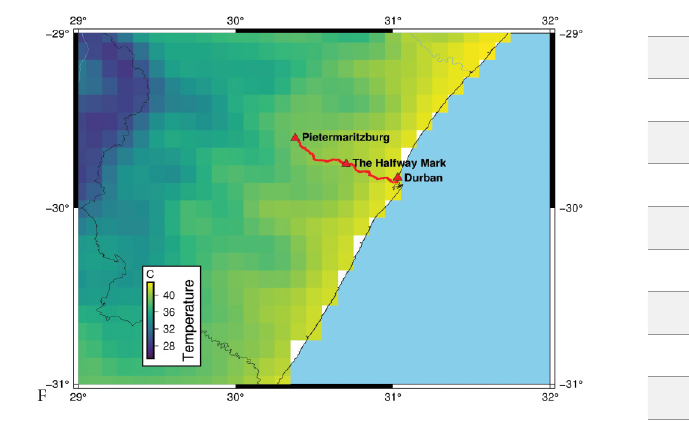
Figure 1: Mean temperature climatology (derived from ERA-5 2-m temperature) for August in the region of interest is represented here as an indication of the temperature gradient between the coastal and inland areas along the route. Indicated on the map are Pietermaritzburg, the halfway mark and Durban in KwaZulu-Natal, South Africa and the route on which the Comrades Marathon takes place.